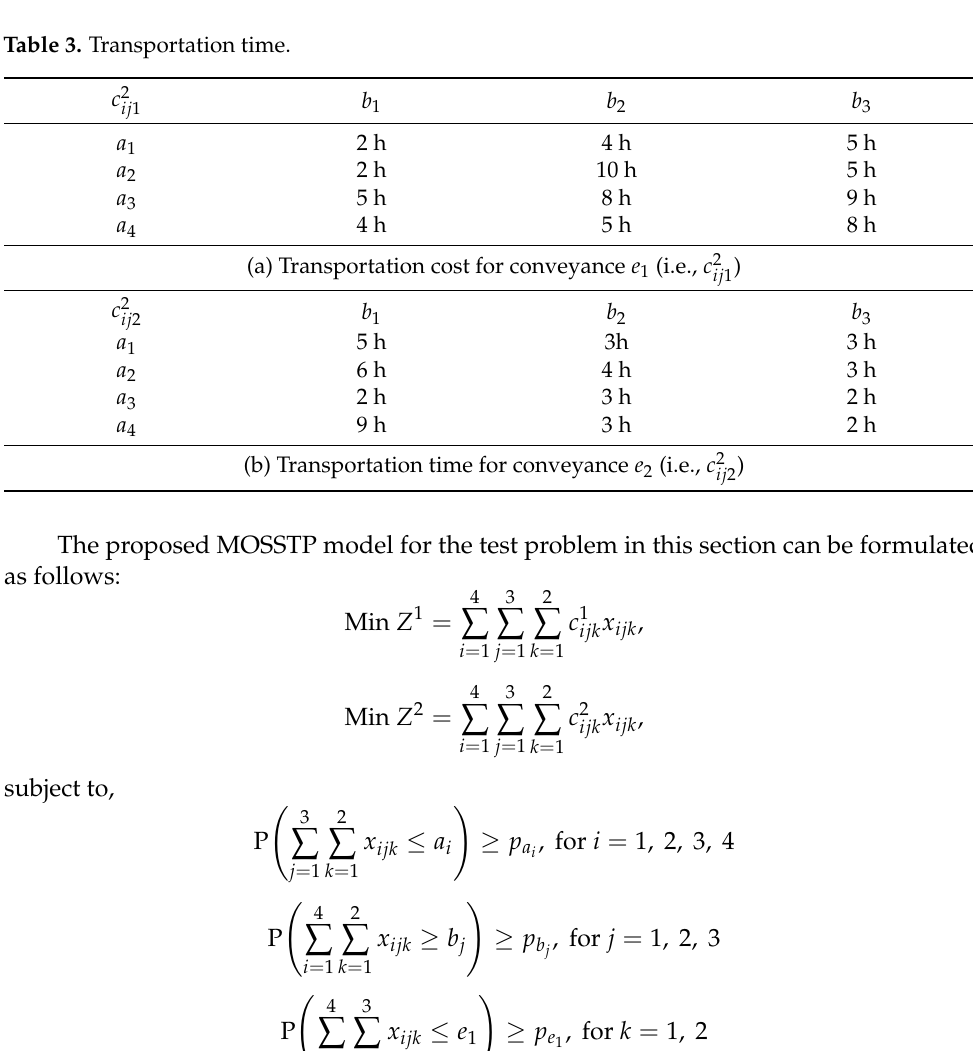
and c 1 for two conveyances, respec- ij 1 ij 2 and c 2 for two conveyances, respec- ij 1 ij 2